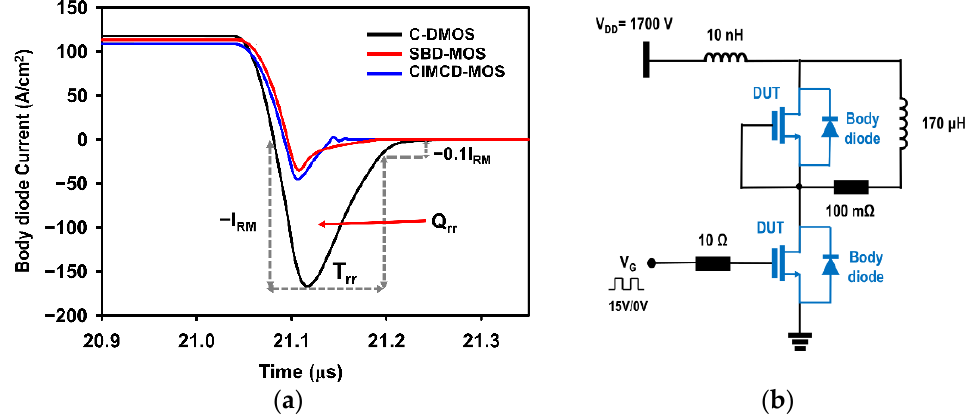
Figure 10. ( a ) Comparison of the reverse recovery characteristics of the C – DMOSFET, SBD – MOSFET, and CIMCD – MOSFET. ( b ) Double pulsed test circuit diagram.